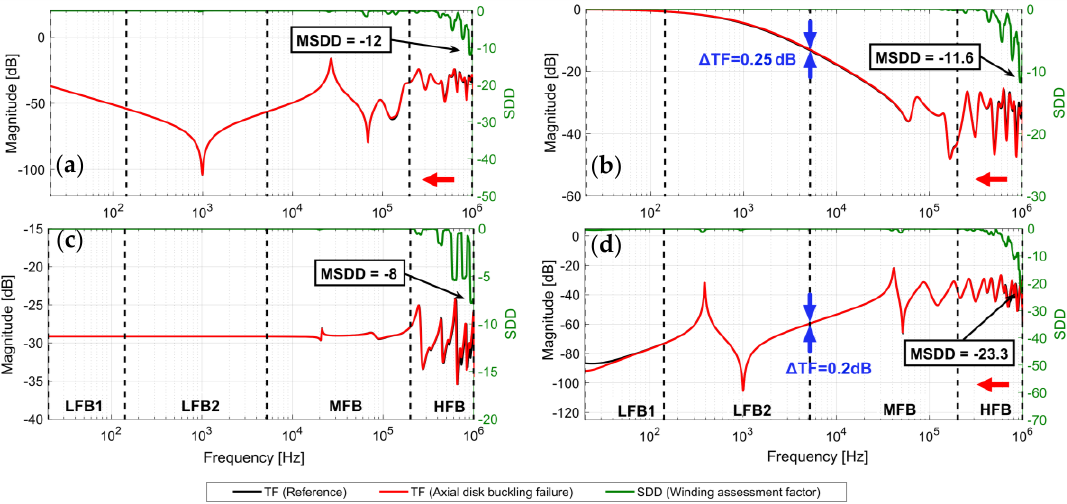
Figure 23. TFs of healthy and disk buckling failure in B-phase HV winding (vector group YNyn0) and SDD as a measure of deviation between TFs; ( a ) HV-OC, ( b ) HV-SC, ( c ) IIW, ( d ) CIW.